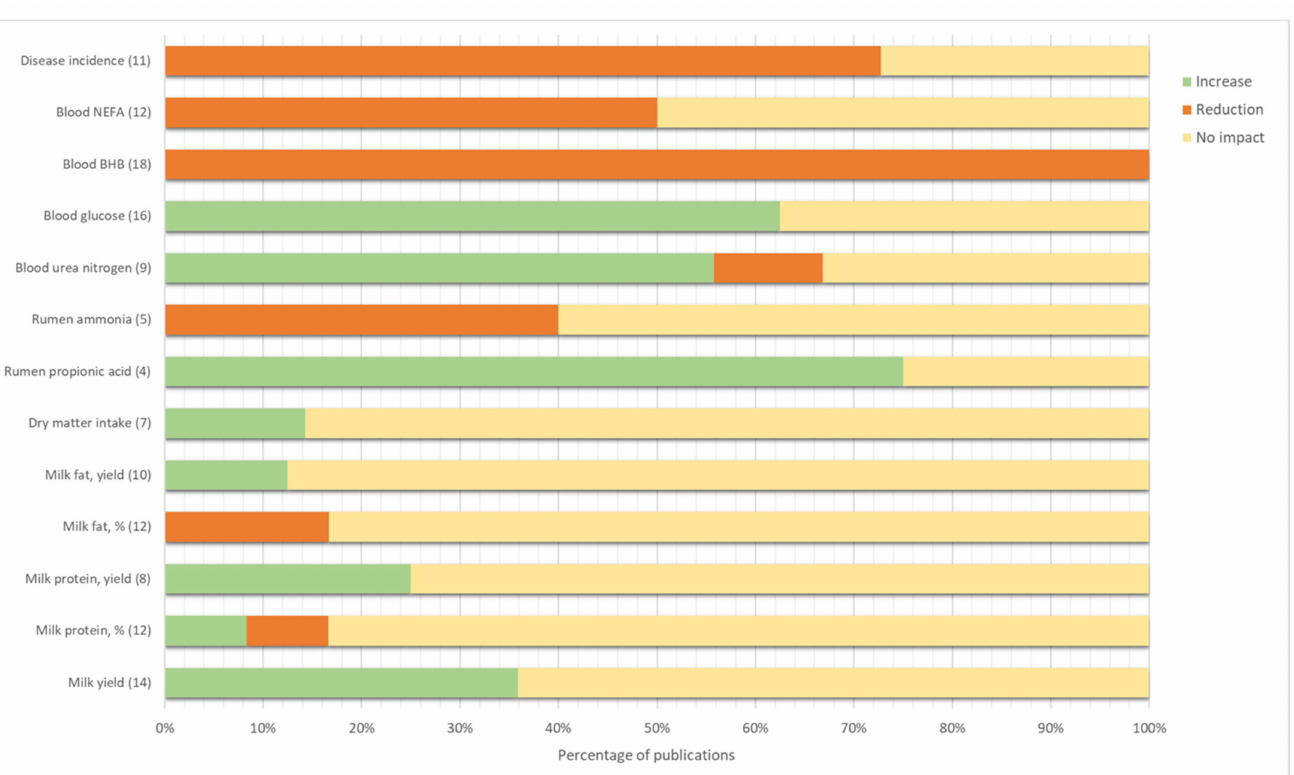
Figure 2. Percentage of publications that demonstrated an impact on a given outcome of monensin administration in early lactation. The effect was considered significant when differences between monensin and control had p -values lower than 0.05. No impact corresponds to non-significant differences ( p -value > 0.05). The number of publications that measured the outcome is given within brackets. BHB = β -hydroxybutyrate; NEFA = non-esterified fatty